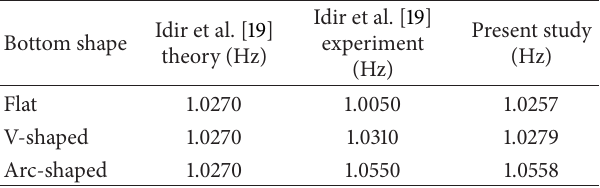
Table 3: Comparison of the fundamental frequencies by Idir et al. [19] and present